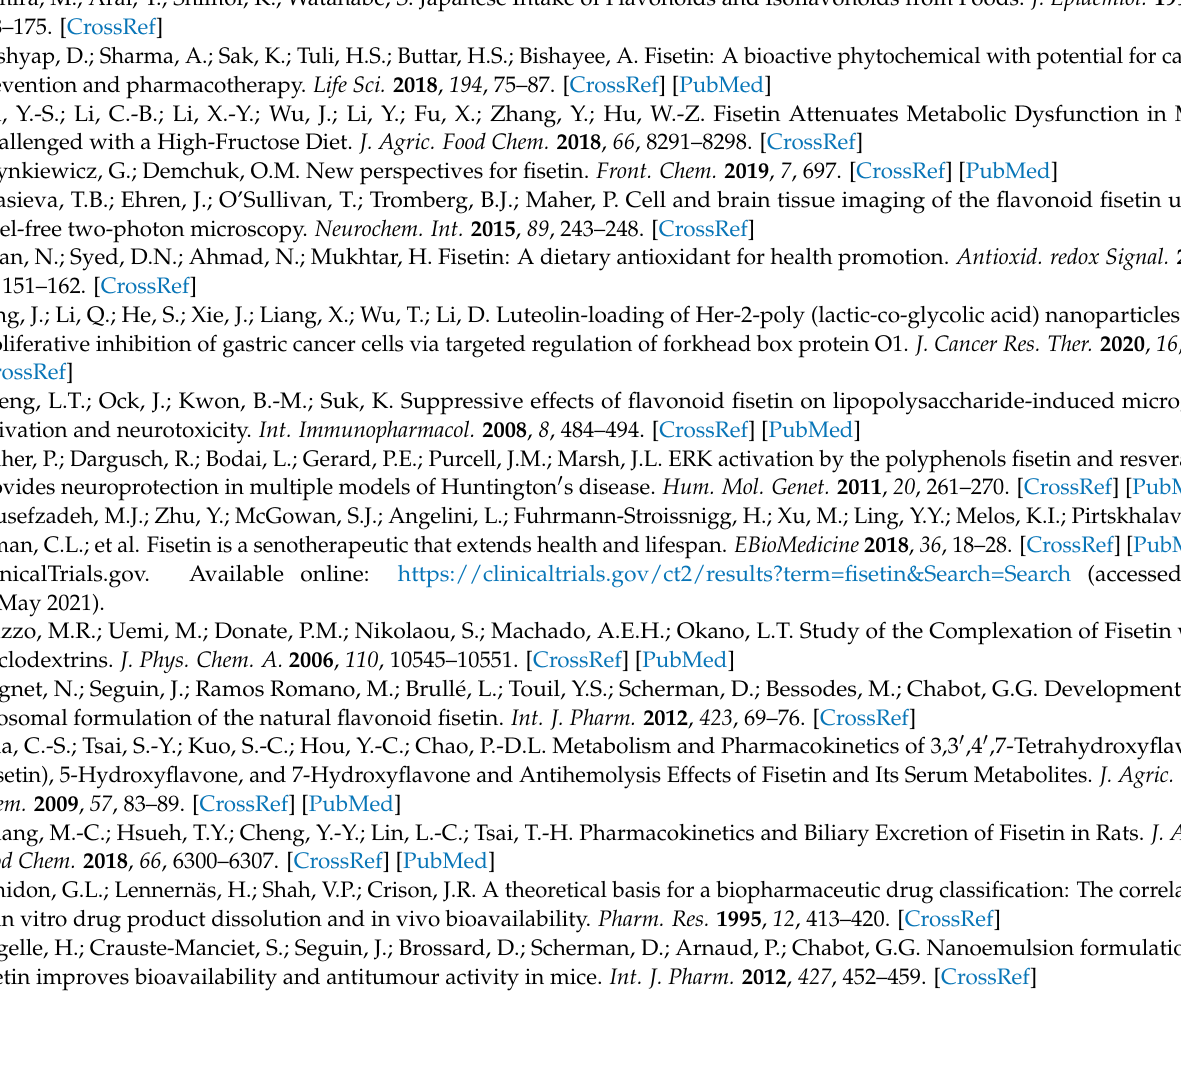
Supplementary Materials: The following are available online. Figure S1 HPLC chromatography of FST-NP in pH 7.4 medium at different time